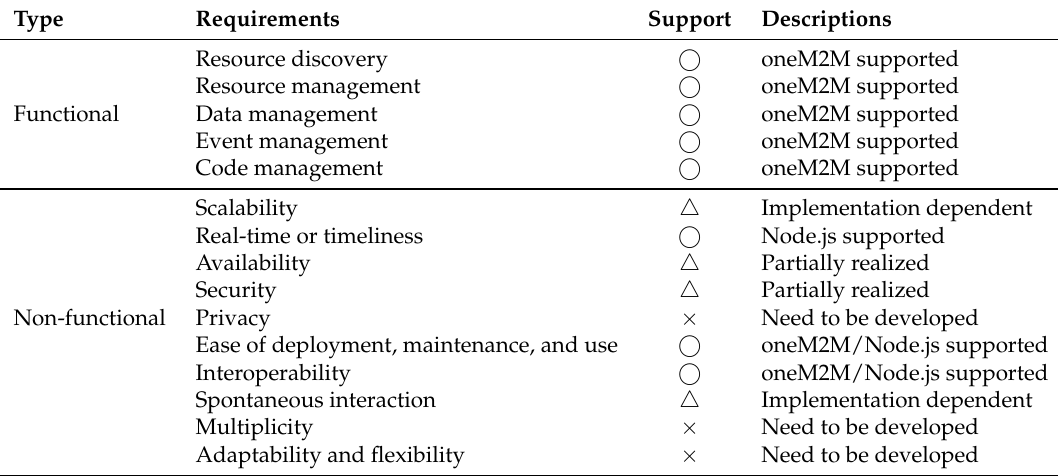
Table 4. A summary of how the functional and non-functional requirements are realized in the proposed oneM2M-based middleware